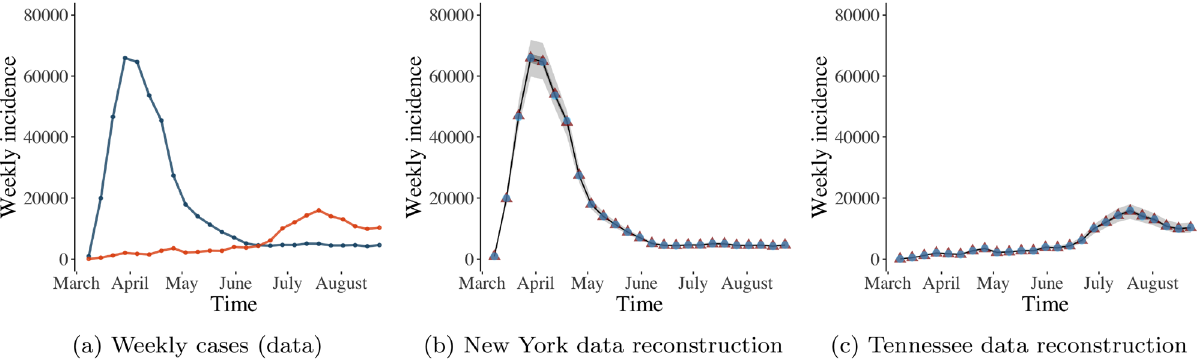
Figure 1. The weekly data of COVID-19 cases for New York (blue) and for Tennessee (orange) from March 1, 2020 through August 31, 2020 are shown in ( a ). The reconstructed weekly cases for New York and for Tennessee over the same time period, based on our SIR model with time-varying reporting rate p t , are displayed in ( b ) and ( c ), respectively. In ( b ) and ( c ), which show our model-based data reconstruction, blue triangles, red triangles, black lines, light-shaded grey areas and dark-shaded grey areas represent the original data, posterior means, posterior medians, 75% credible intervals and 95% credible intervals,